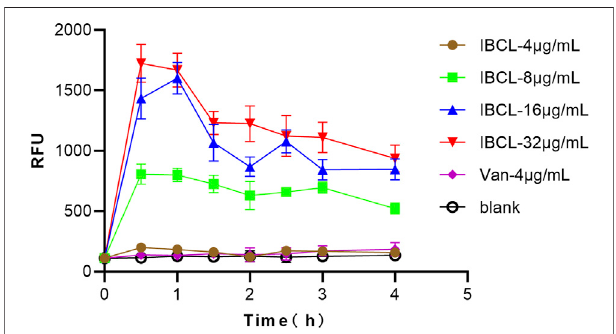
FIGURE 6 | Fluorescence measurement of propidium iodide of C. dif fi cile ATCC43255 bacteria treated with different concentration of IBCL and Vancomycin.